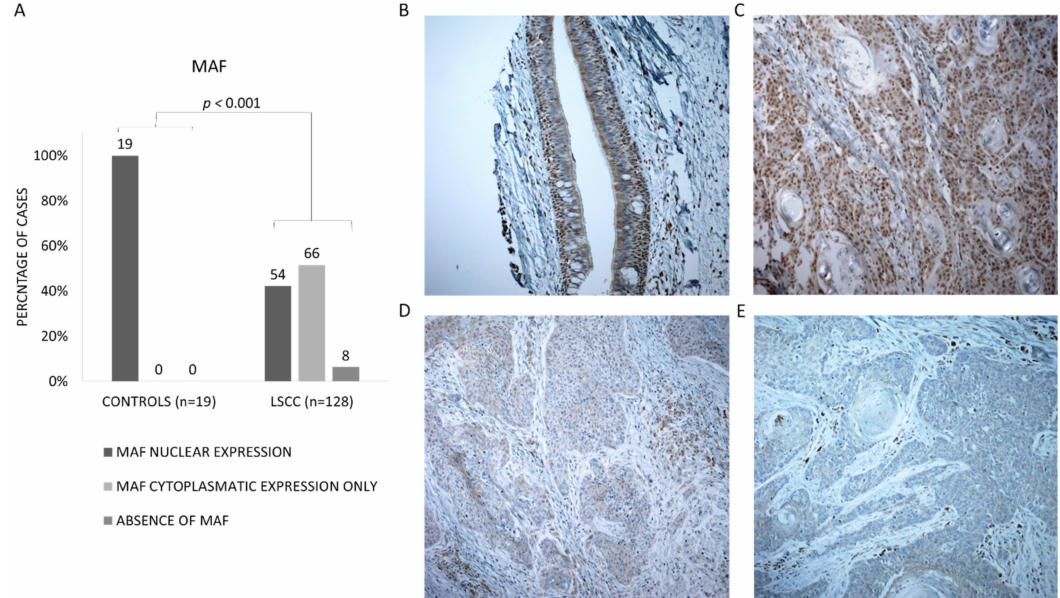
Figure 2. Immunohistochemical staining of MAF in LSCC. ( A ) Cellular distribution of MAF protein in normal mucosa and primary LSCC. ( B – E ) Representative microphotographs of MAF immunohistochemical staining (brown color = positive reaction). ( B ) Nuclear MAF expression in normal mucosa, ( C ) LSCC tumors with nuclear c-MAF expression, ( D ) LSCC tumors with cytoplasmic MAF expression, ( E ) LSCC tumor with absence of MAF